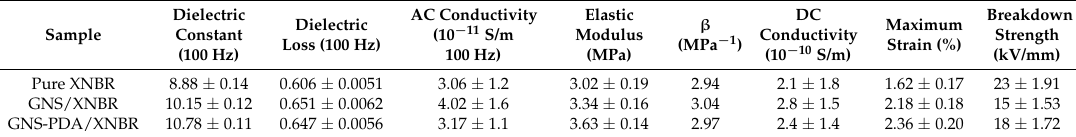
Table 1. Summary of electromechanical properties of pure XNBR and XNBR